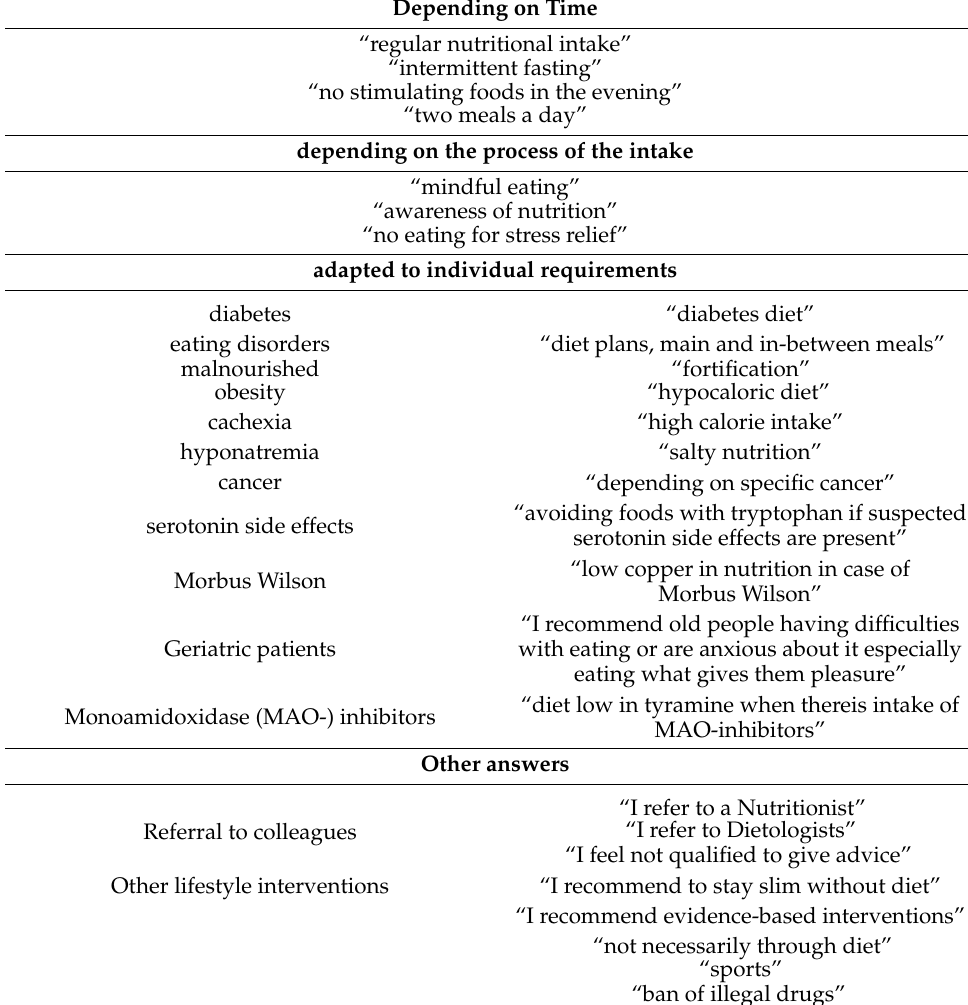
Table 4. List of answers in a free text field regarding dietary specifications given by psychiatrists, psychologists, psychotherapists, and psychiatrists/psychologists in